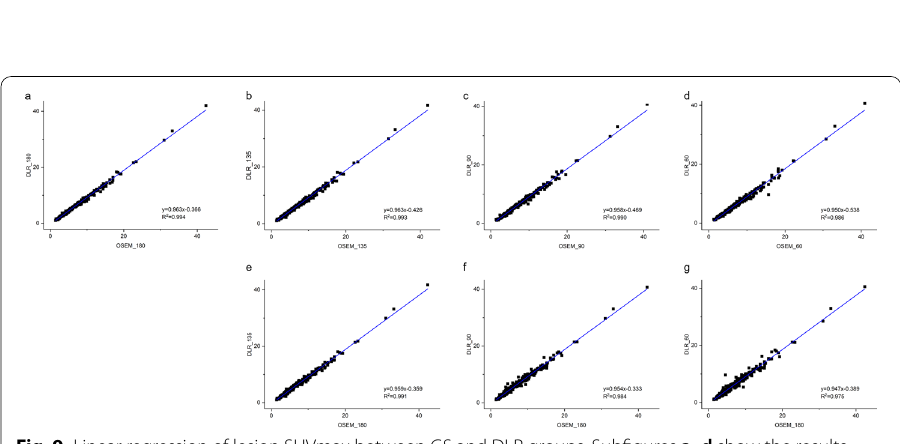
Fig. 9 Linear regression of lesion SUVmax between GS and DLR groups. Subfigures a – d show the results between GS and DLR images with the same acquisition time. Subfigures a , e , f and g indicate a strong relationship between DLR groups and the reference GS_180 group. The above results demonstrate the good agreement of SUV between the groups. SUV, standardized uptake